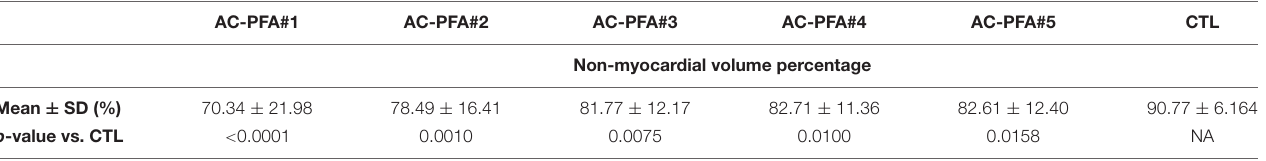
FIGURE 4 | Atrial findings at the end of follow-up. (A) Epicardial circular discoloration observed on the left atrium; (B) diffuse endocardial discoloration in proximity of the pulmonary veins; (C) Posterior view of the 3D rendering of the manual segmentation of normal myocardium (red) and non-myocardial tissue (green), with white arrows pointing at pulmonary vein ostia; (D) Posterior view of the 3D rendering of an age-matched non-ablated control, segmented with same criteria; (E) trichrome staining of left atrium which underwent AC pulsed electric field ablation, showing circular continuous and transmural lesions; (F) trichrome staining of age-matched non-ablated control. Scalebar is 3 mm. TABLE 3 | Volumetric ratio of the non-myocardial tissue as calculated from manual segmentation of the 9.4T MRI atrial